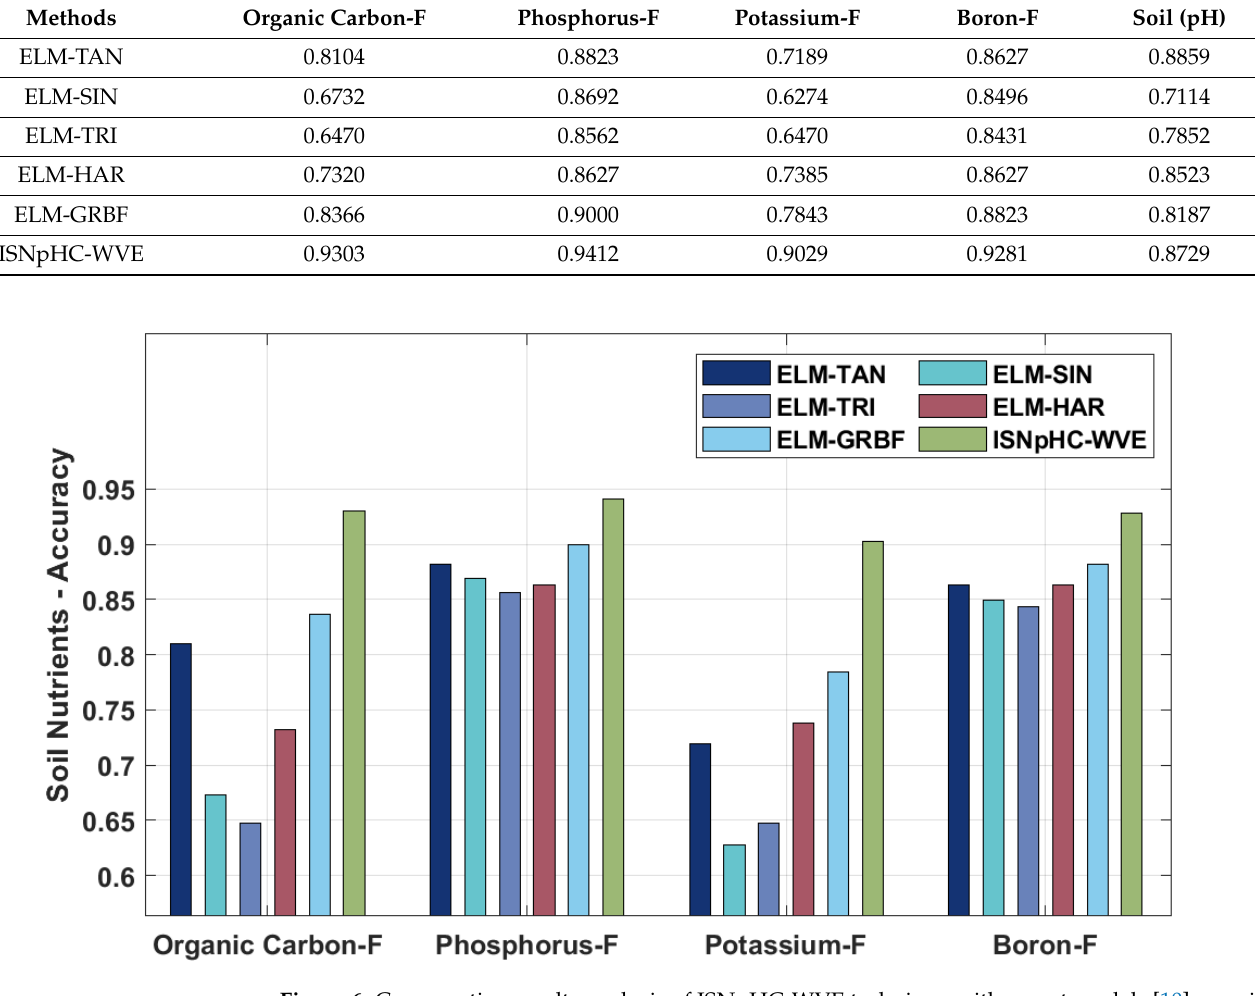
Figure 7. Comparative results analysis of ISNpHC-WVE technique on soil pH classification. Thereafter, on investigating the classification outcomes of P-F, the ISNpHC-WVE method gained an increased accuracy of 0.9412 whereas the ELM-TAN, ELM-SIN, ELM- TRI, ELM-HAR, and ELM-GRBF methodologies accomplished a minimal accuracy of 0.8823, 0.8692, 0.8562, 0.8627, and 0.9000 correspondingly. In addition, on examining the classification results of K-F, the ISNpHC-WVE technique achieved a higher accuracy of